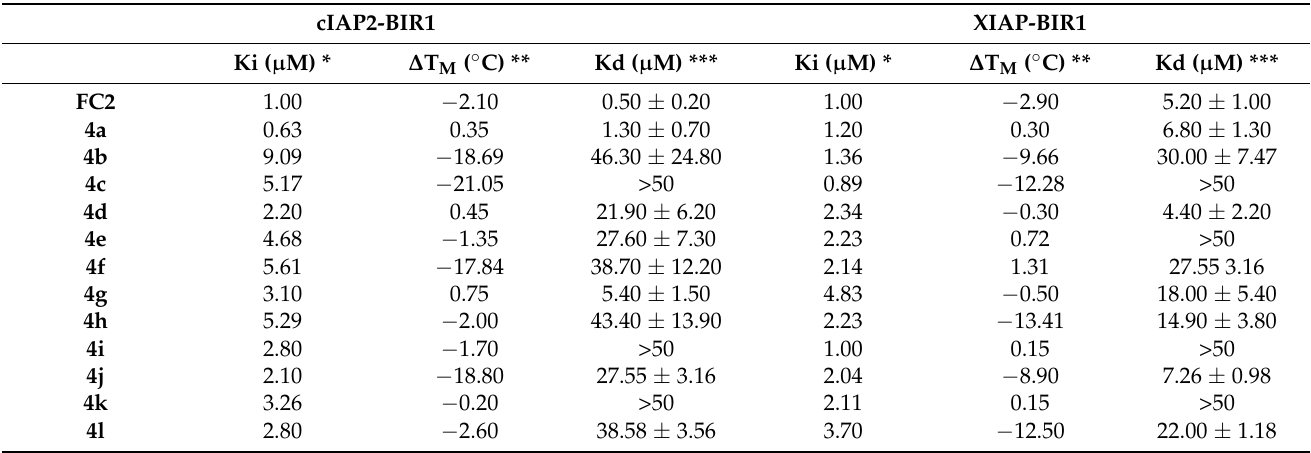
Figure 1. The Baculoviral IAP Repeat (BIR) domain is composed of three to five α -helices and a central three-stranded β -sheet. In type I BIRs, the hotspot targeted by FC2 (grey sticks in cIAP2, deep blue sticks in XIAP) corresponds to the N-terminal α -helices ( a ). The sequence of the structural hotspot ( α 1-turn- α 2) is conserved among homologous type I BIRs, as shown in the sequence alignment ( b ) performed with Clustal [22]. Several electrostatic interactions ( c , blue lines) and hydrophobic contacts ( c , grey dashed lines) between residues ( c , points) from α 1 (blue shade), the turn (green-yellow shades) and α 2 (red shade) stabilize the folding of the structural hotspot in a conservative manner among homologous BIRs (the numbering of the residues is referred to the deposited Protein Data Bank structures 3M0A [15], chain D for cIAP2 and 2POP [16], chain B for XIAP; panel b and c were adapted with permission from Pymol [23] and RING 2.0 [24]). Table 2. FC2 and FC2 derivative effect on type I